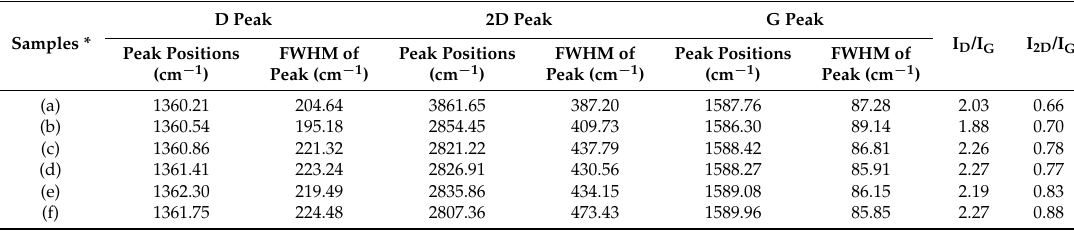
Table 1. Raman peak positions and FWHM, and intensity ratios of I D /I G and I 2D /I G . D Peak 2D Peak G Peak Samples *